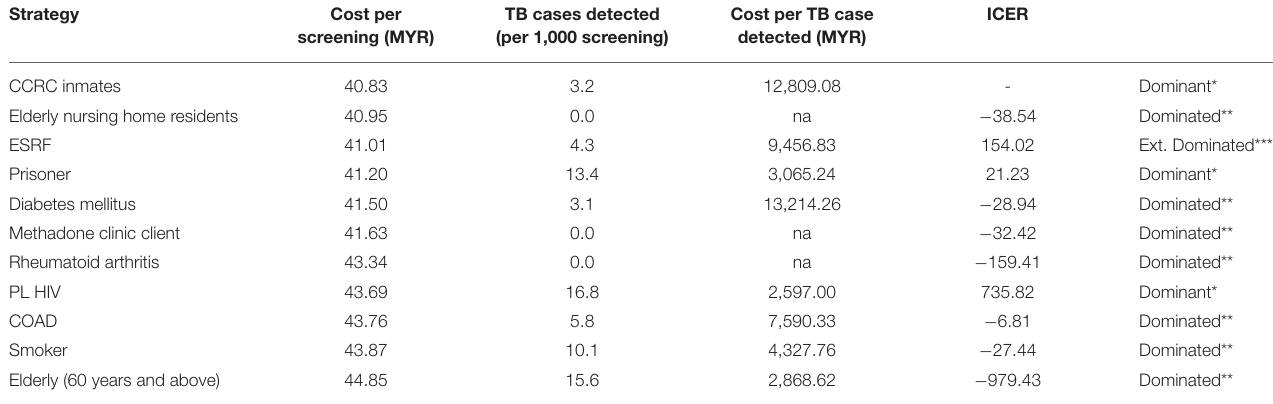
TABLE 5 | Results of cost-effectiveness analysis of different high-risk group TB screening. Strategy Cost per TB cases detected screening (MYR) (per 1,000 screening)